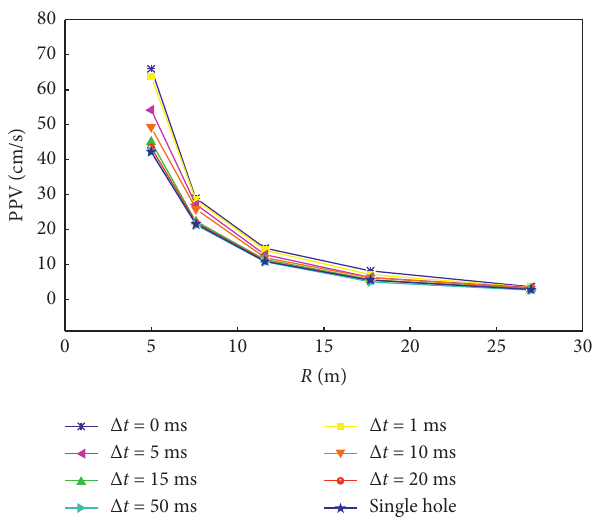
Figure 14: Blasting vibration PPVs with different delay